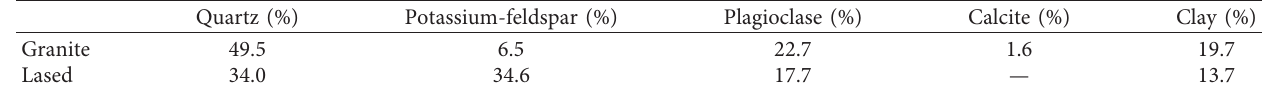
Figure 4: Surface morphologies of granite by fiber laser irradiation. (a) Full view of laser perforation, (b) Nonirradiated surface. (c) Glazed clusters on the perforation surface. (d) Cracks on the edge of perforation. Table 6: Compositions of granite before and after laser perforation.